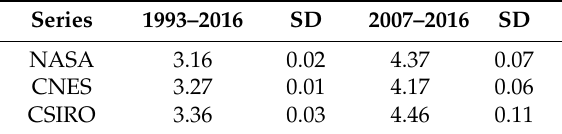
Global SLR rates and respective standard deviation (SD) for two different periods (in mm/year), obtained with satellite altimetry MSL anomalies from three international data centers.